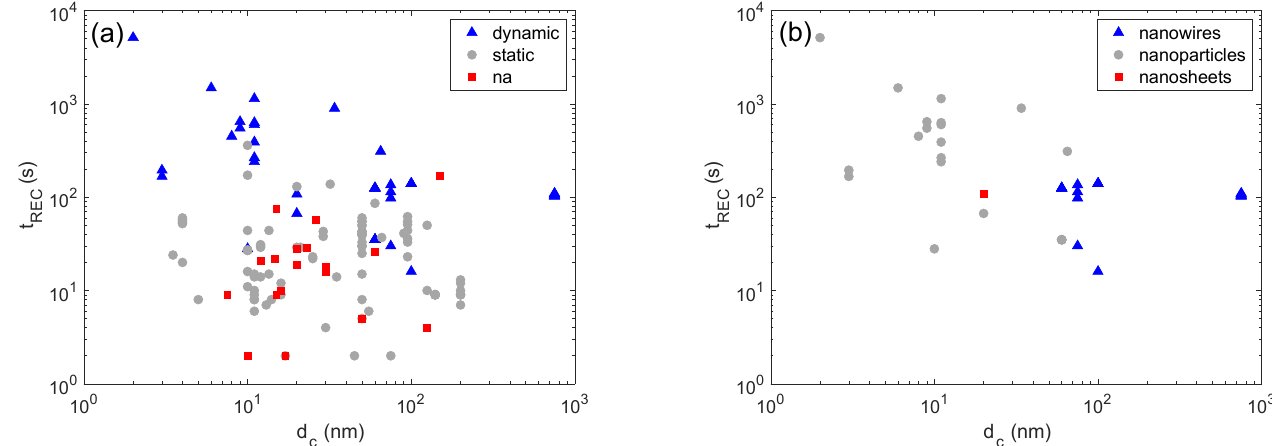
Figure 6. Effects of crystallite size (d c ) on recovery times (t REC ). Plot showing the dependence of t REC on dc for the whole set of measurements; different colors identify different setups ( a ). Plot showing the dependence of t REC on d c for the set of measurements carried out with dynamic setups; different colors identify different crystallite shapes ( b ). In all plots, ‘na’ stands for ‘not available’—for those papers that did not provide enough detail to properly identify the class of the descriptive parameter.